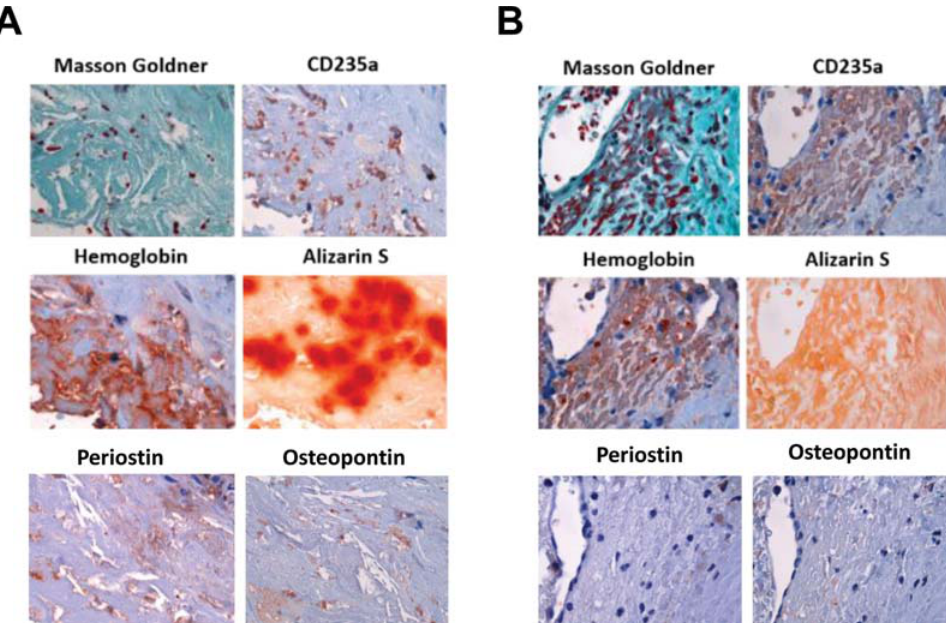
Fig. 5 Colocalization of lysed and intact erythrocytes and hemoglobin with areas of calci fi cation in serial sections of human vascular lesions. ( A ) Representative example showing the presence of lysed erythrocytes and extracellular hemoglobin in close association with Alizarin S-positive material. ( B ) Representative example showing the presence of intact erythrocytes and cell-associated hemoglobin in an area without calci fi cation; 1,000-fold magni fi cation. Table 5 Frequency of erythrocyte lysis in human valvular